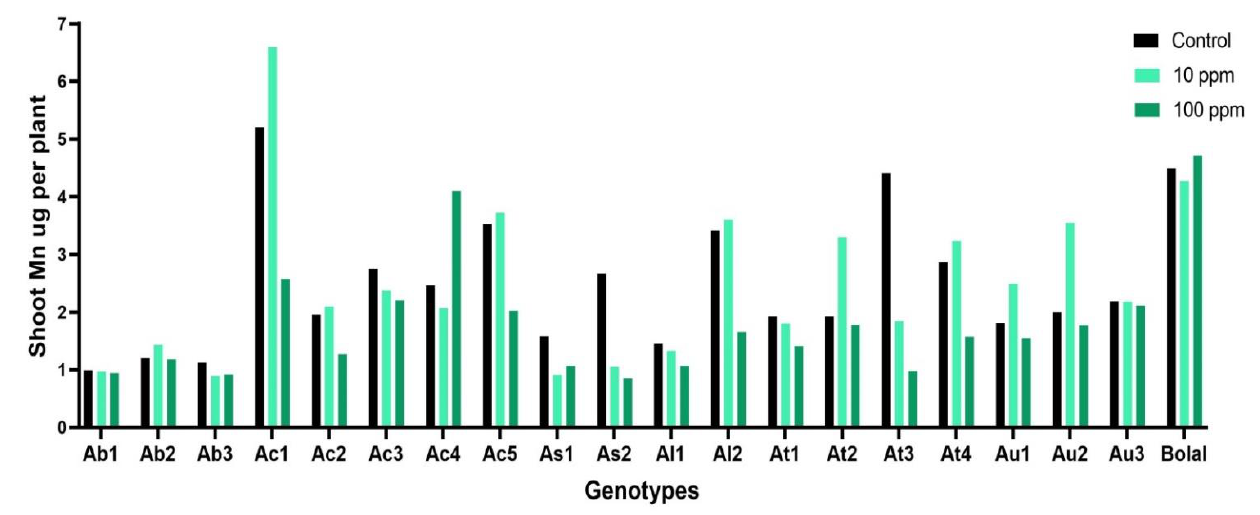
Figure 5. Variation in the SMn (shoot manganese) uptake of 19 Aegilops genotypes and the B tolerant check cultivar, Bolal 2973, in Control (3.1 µ M B), toxic B (10 ppm B), and highly toxic B (100 ppm B).